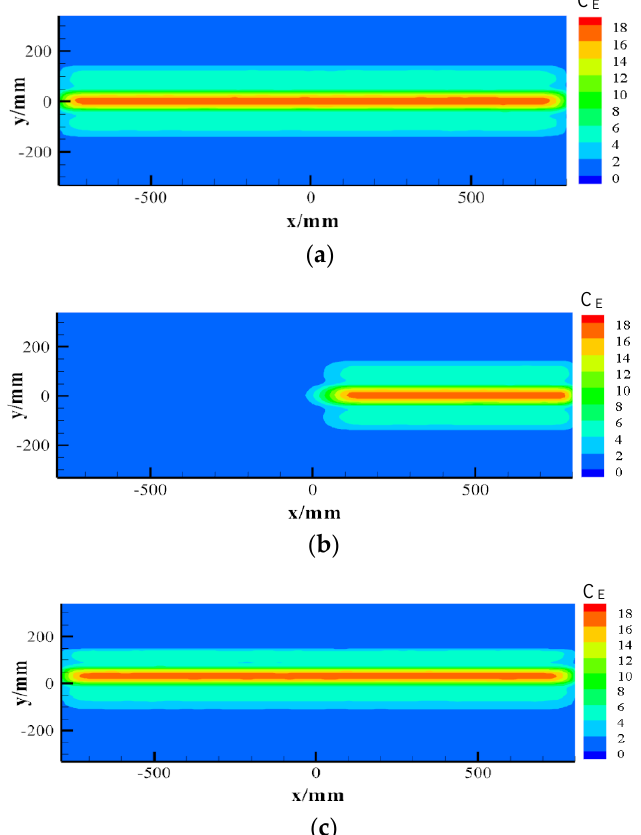
Figure 12. The 2-D heat flux distributions considering solar cone angle with different tracking errors. ( a ) No tracking error. ( b ) Tracking 3° along the x-axis direction. ( c ) Tracking error 3° along the y-axis direction.